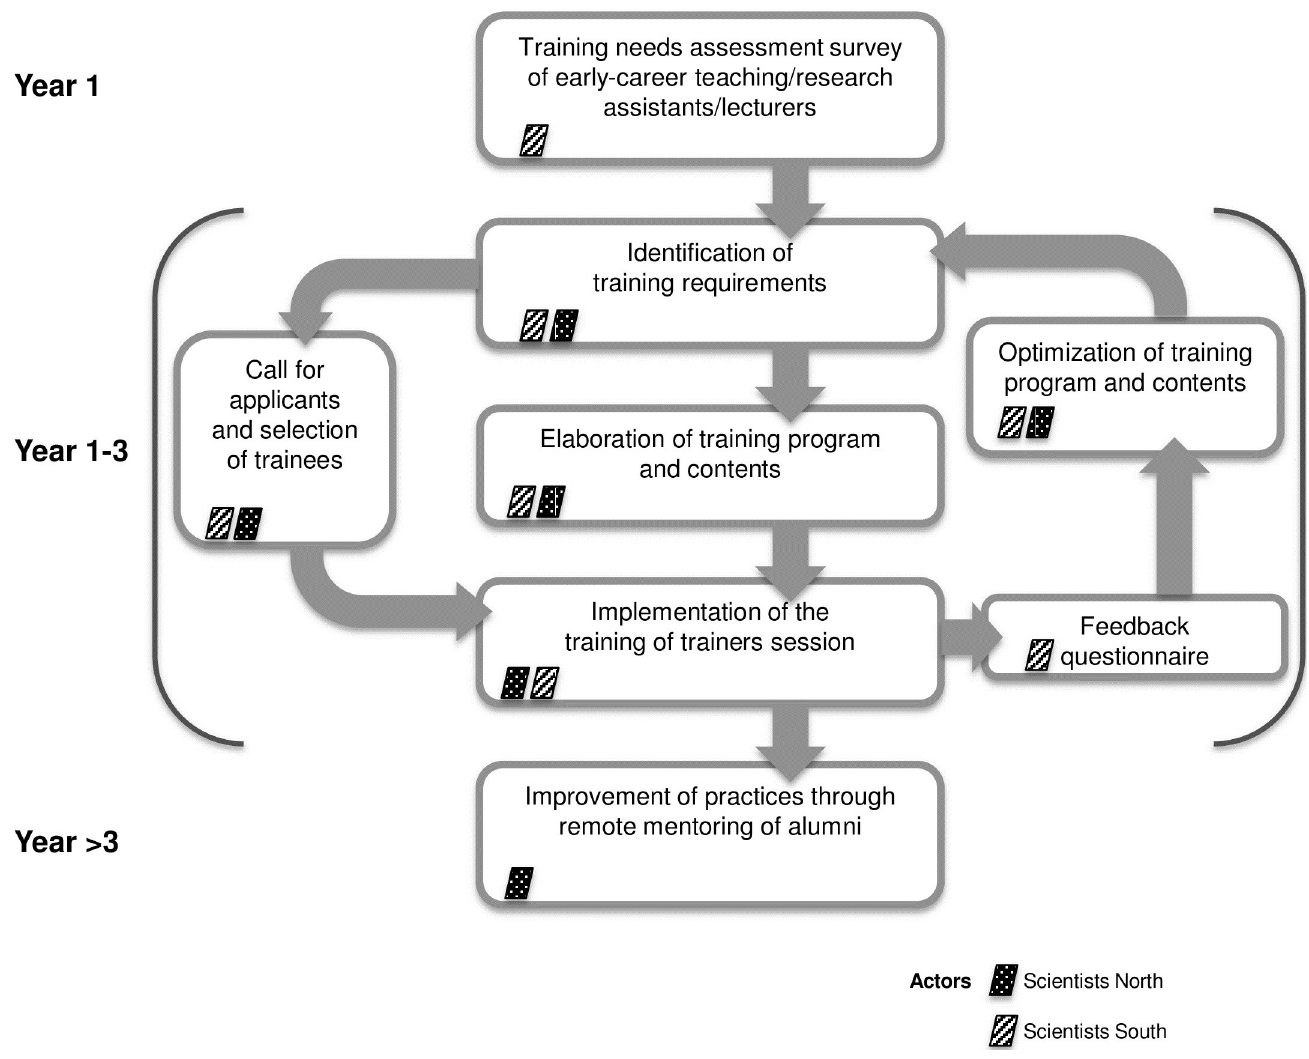
Fig 3. Structure of the MooSciTIC project.